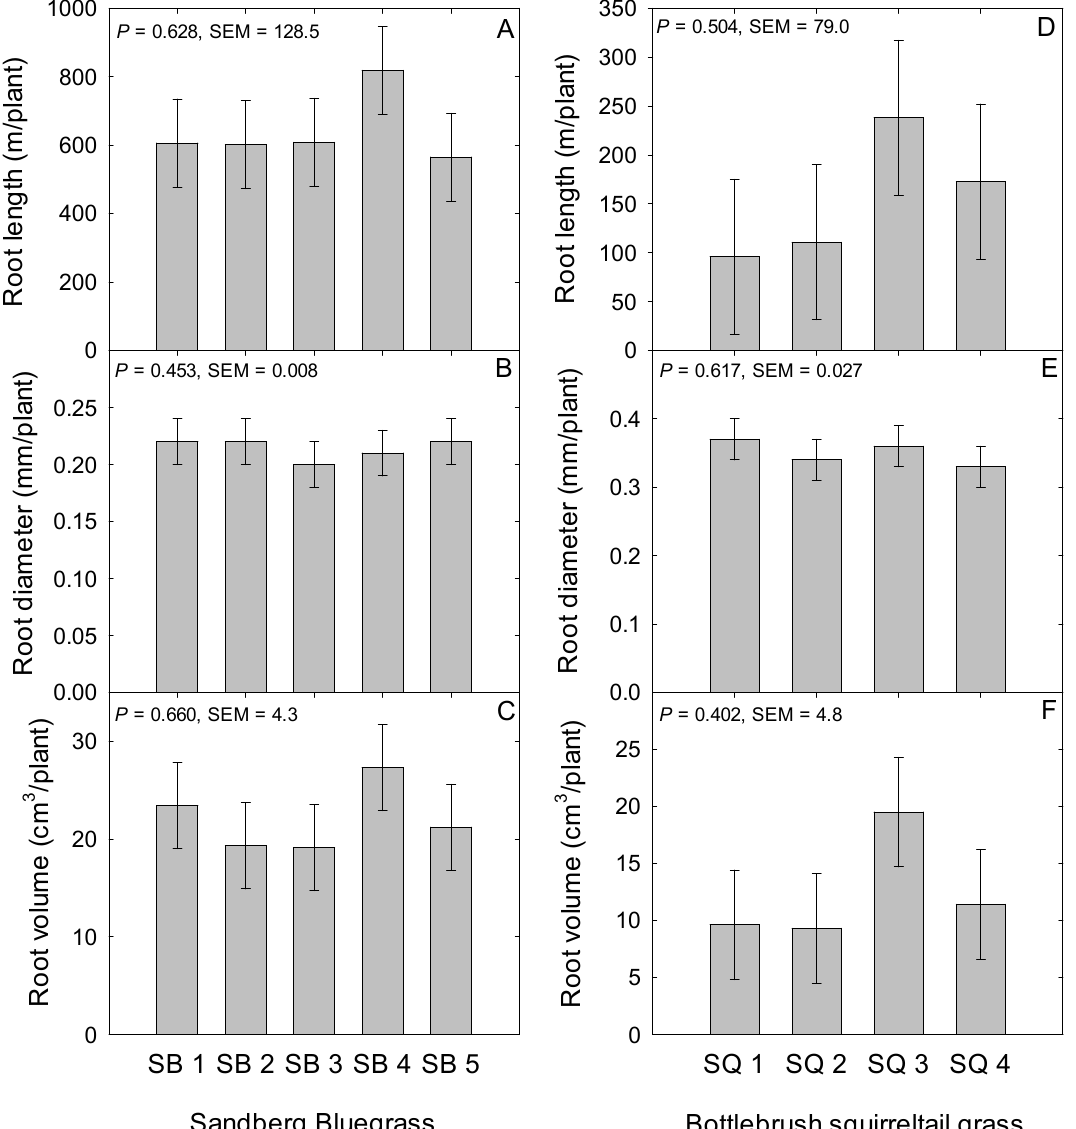
Figure 2. Mean ( A , D ) total root length in meters, ( B , E ) root diameter in millimeters, ( C , F ) root volume in cubic centimeters per plant of Sandberg bluegrass and Bottlebrush squirreltail evaluated under greenhouse conditions during 2015 to 2016 at the University of Nevada, Reno, USA. SB 1; Button Point (LP), SB 2; Panther Valley (LP), SB 3; Winnemucca Mountain (LP), SB 4; Hanford (CV), SB 5; Mountain Home (CV), and Bottlebrush squirreltail, SQ 1; George St. Sonoma (LP), SQ 2; Grass Valley (LP), SQ 3; Toe Jam Creek (CV), and SQ 4; Vale (CV). LP; local population, and CV;